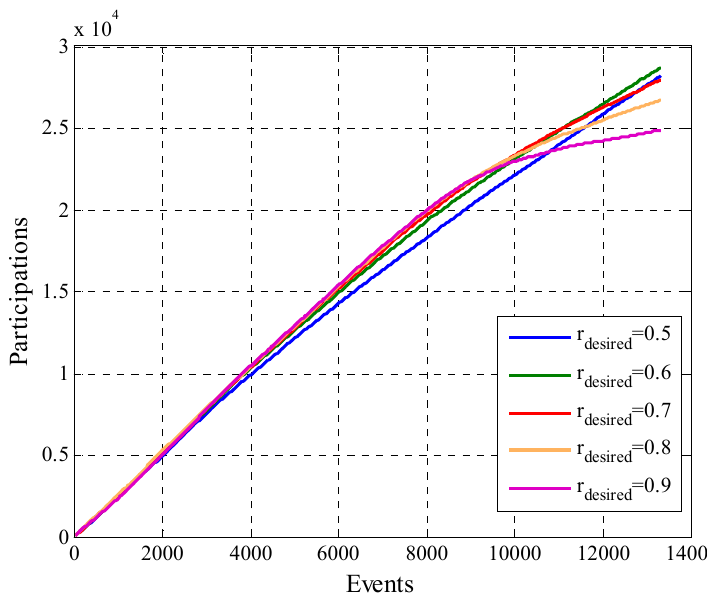
Figure 26. Platform utility for configurations with different values of 𝑟 (cid:3031)(cid:3032)(cid:3046)(cid:3036)(cid:3045)(cid:3032)(cid:3031) .